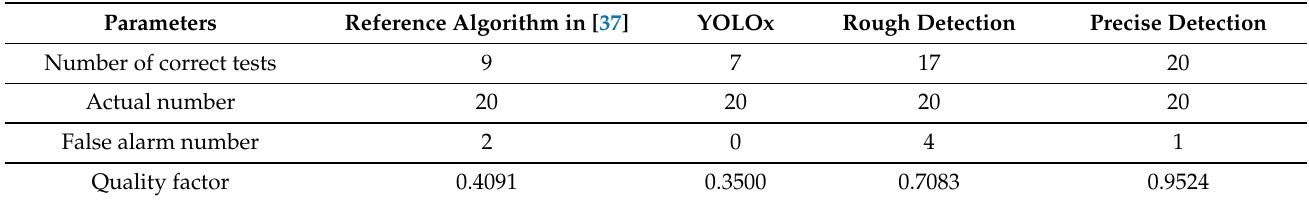
Table 3. Results of ship